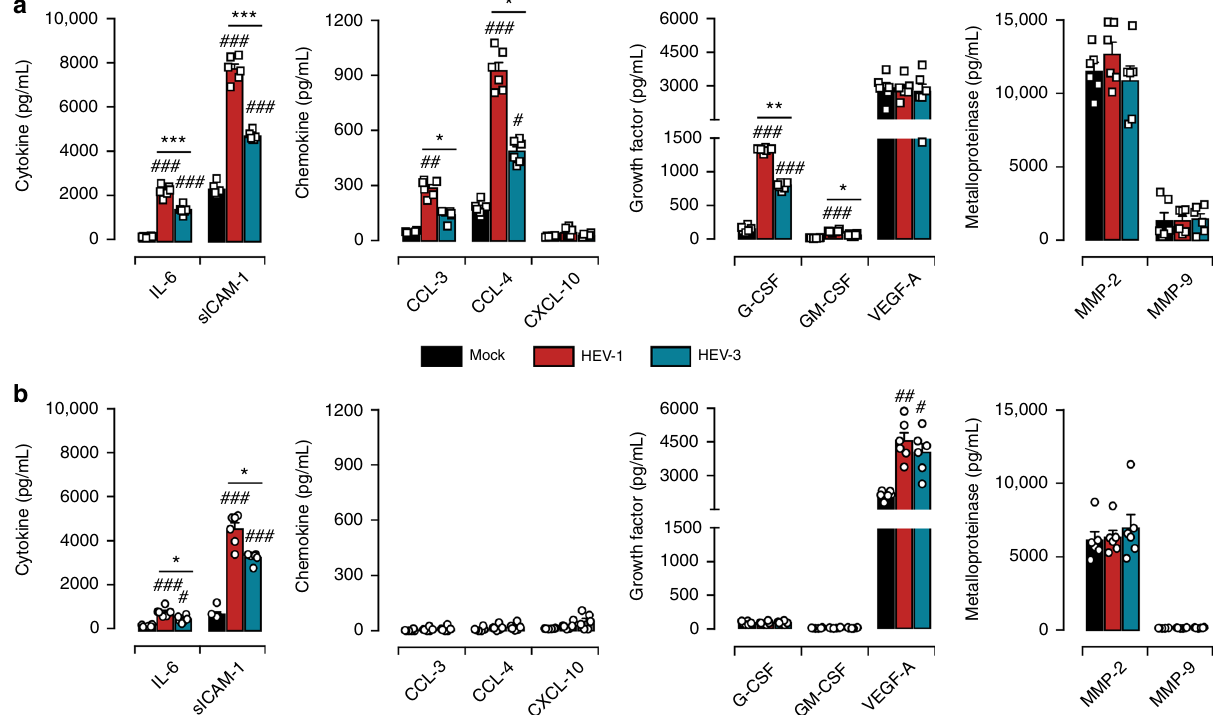
Fig. 7 HEV-1 alters the secretory functions of both decidual and placental stromal cells. a , b Cytokine, chemokine, growth factor, and metalloproteinase secretion in decidual a and placental b stromal cell supernatants, measured by multiplex assay two days after mock (black), HEV-1 (red), or HEV-3 (cyan) infection. Data represent mean values ± S.E.M. of six independent donors. * denotes a statistical comparisons made between HEV-1 and HEV-3 infected tissue, and # represents a statistical comparison between mock-infected and HEV-1 or HEV-3 infected tissue. */# P < 0.05; **/## P < 0.01; ***/### P < 0.001 by repeated measures ANOVA with Tukey post hoc